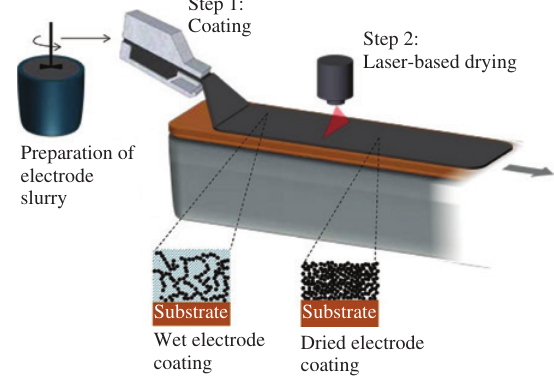
Figure 13: Process chain for the production of thick-film electrodes. For the drying process, the wet electrode is exposed to the line focus of a high-power fiber laser. Reprinted from